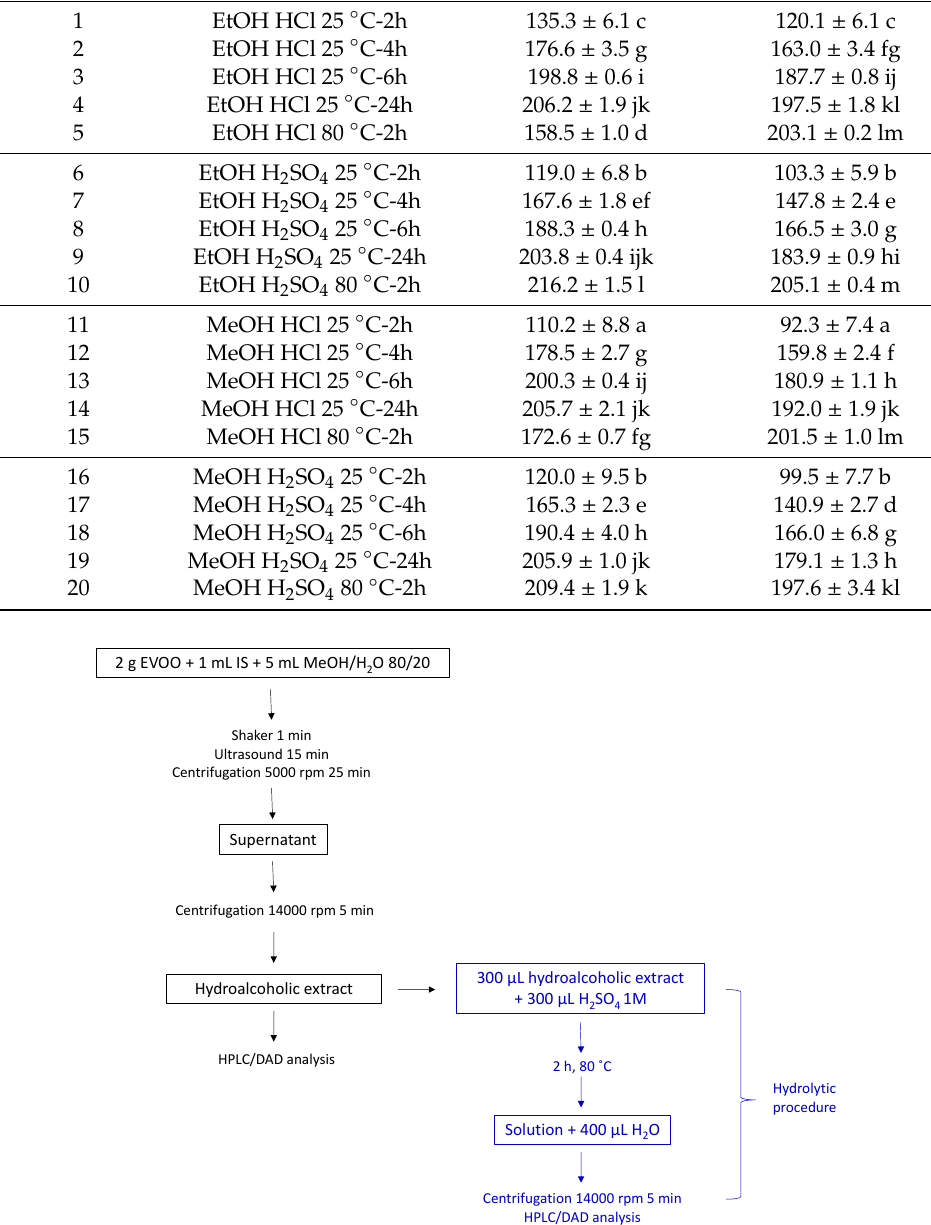
Figure 2. Summary of the proposed method in two successive steps: total phenolic extraction is in black and acidic hydrolysis of the methanol/aqueous extract is in blue.